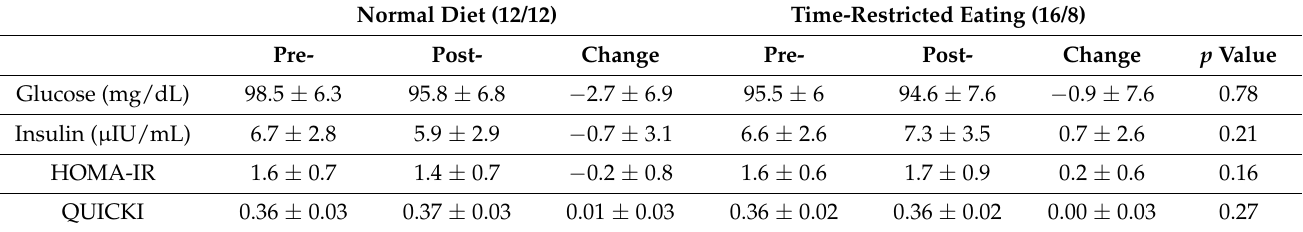
Table 6. Markers of Insulin Resistance and Sensitivity 1